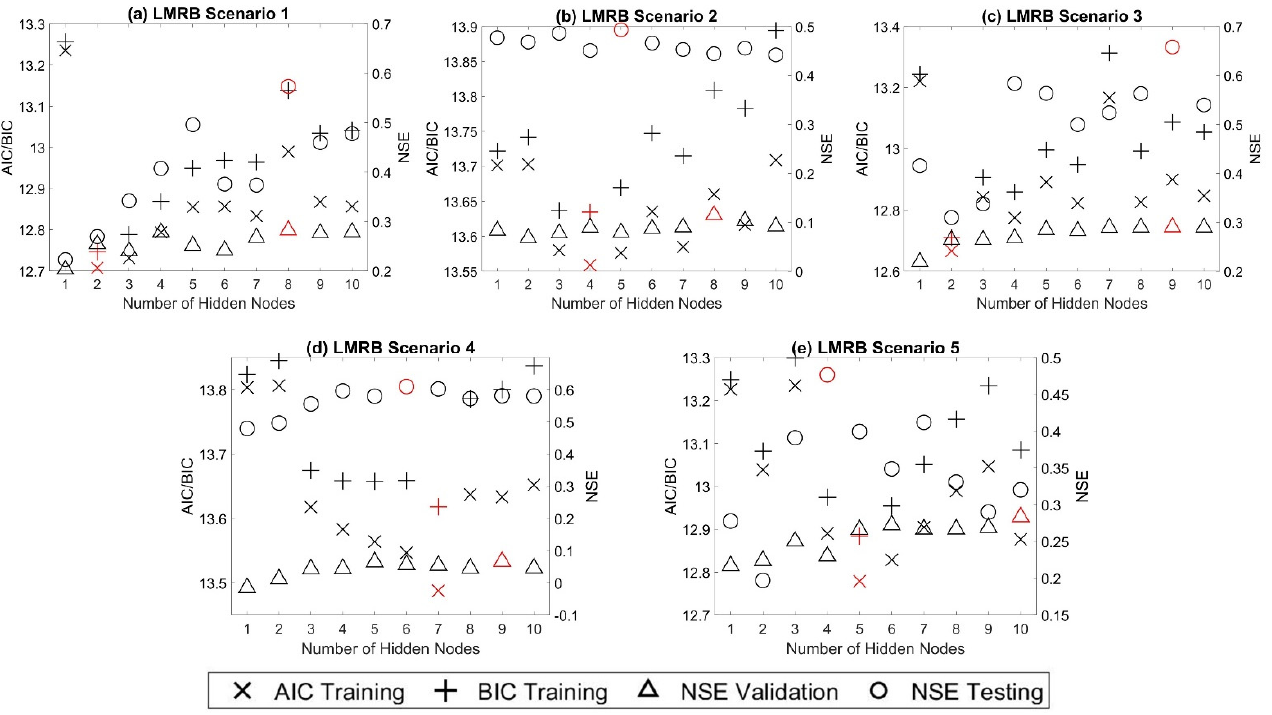
Figure 4. Model statistical performance of prediction scenarios 1 through 5 for the LMRB watershed ( a − e ). The best performance measures of each scenario (i.e., the smallest AIC and BIC, the largest NSE) are highlighted in red.